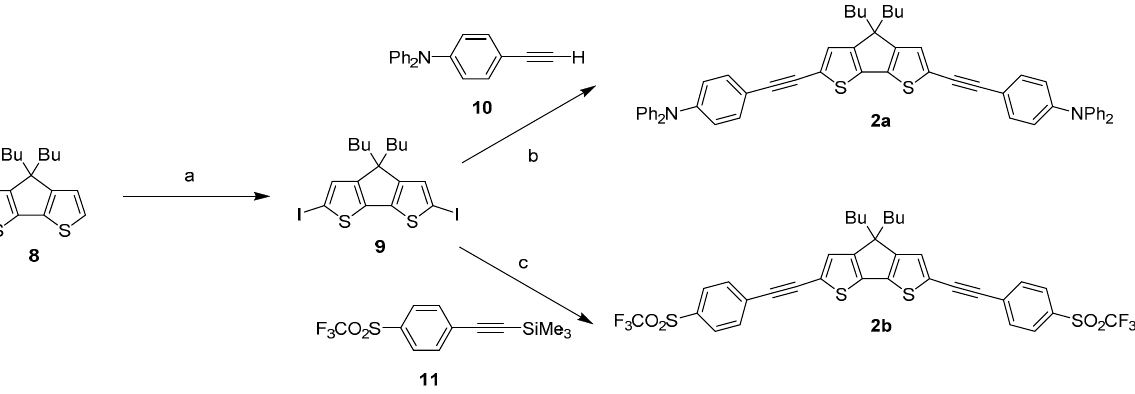
Scheme 3. Synthesis of 2a , b compounds. Reagents and conditions: (a) N -iodosuccinimide, THF (89%); (b) Pd(PPh 3 ) 2 Cl 2 , CuI, NEt 3 , 45 ◦ C, 16 h (45%); (c) TBAF, Pd(PPh 3 ) 2 Cl 2 , CuI, NEt 3 , 45 ◦ C, 16 h (50%). Table 1. Photophysical properties of quadrupoles 1a , b and 2a , b vs. those of 3a and 3b (cid:48) in toluene (unless otherwise stated).